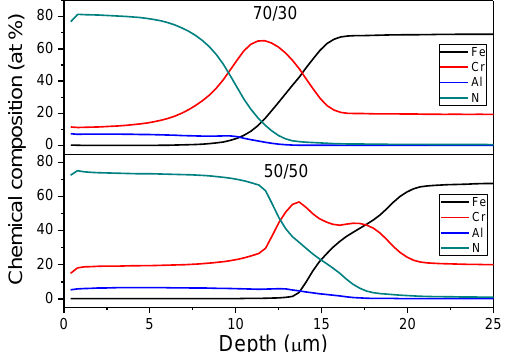
Figure 2. Glow discharge optical emission spectroscopy (GDOES) chemical depth profiling of the Cr 1 − x Al x N coatings.